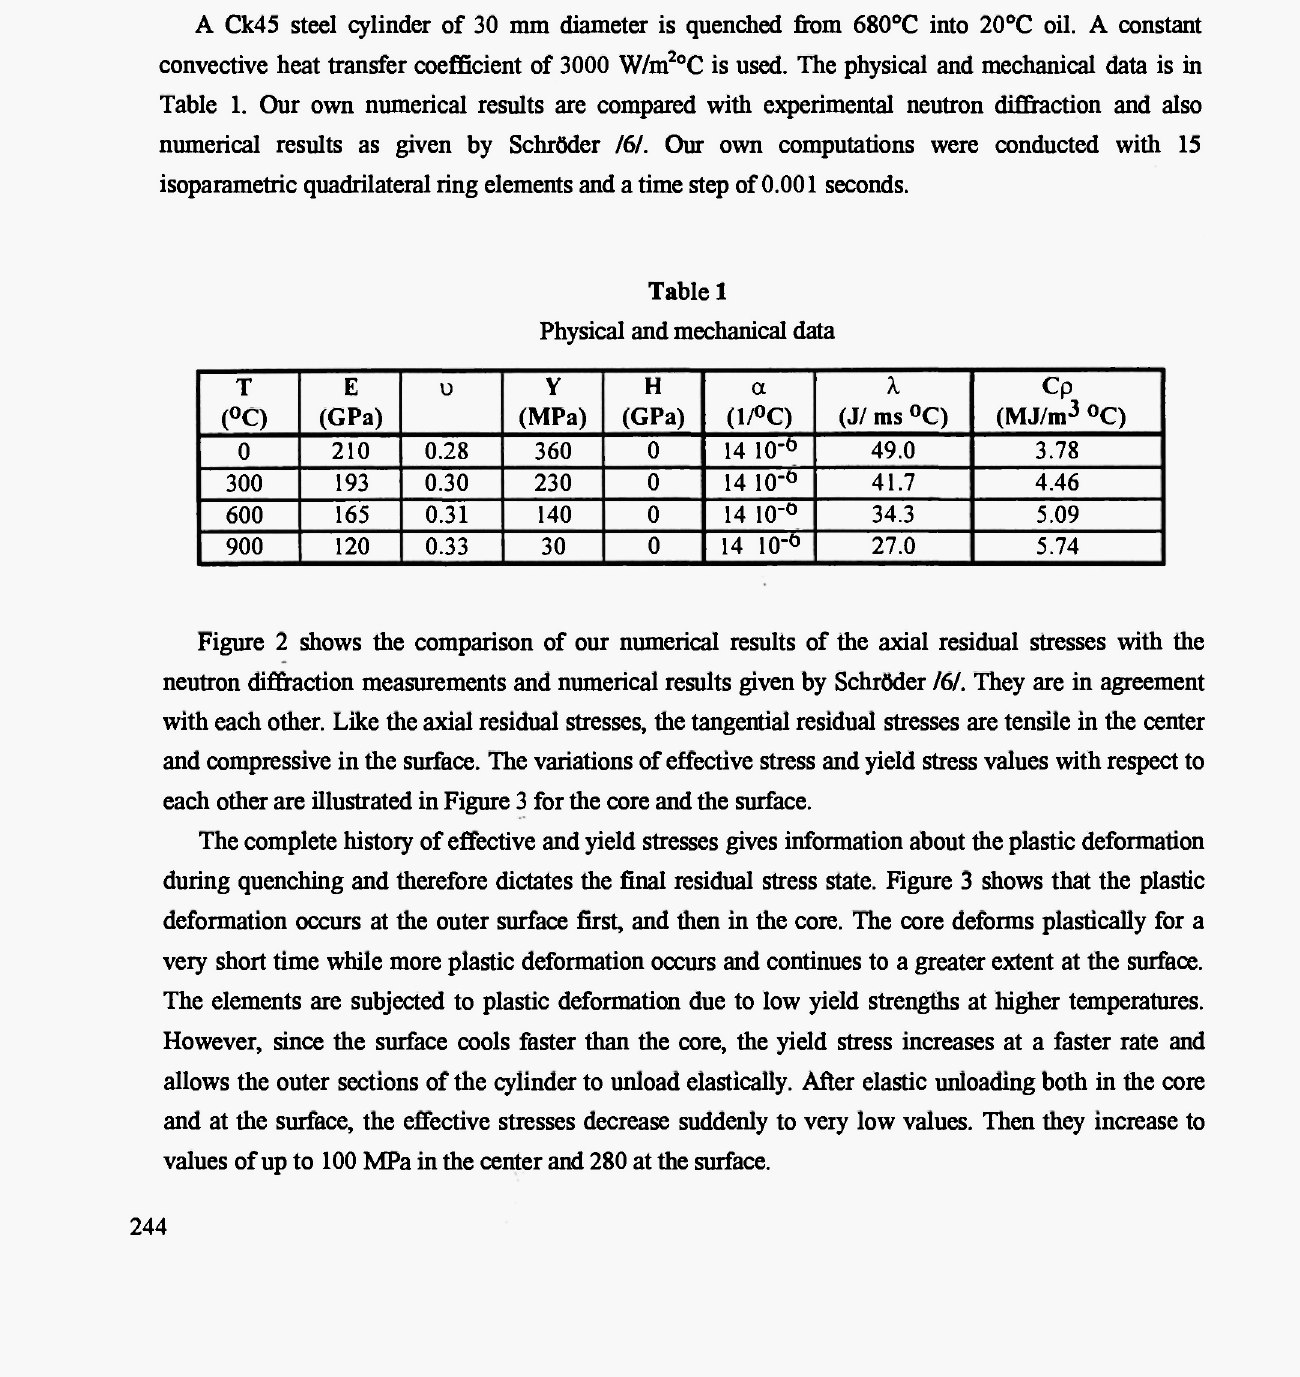
Physical and mechanical